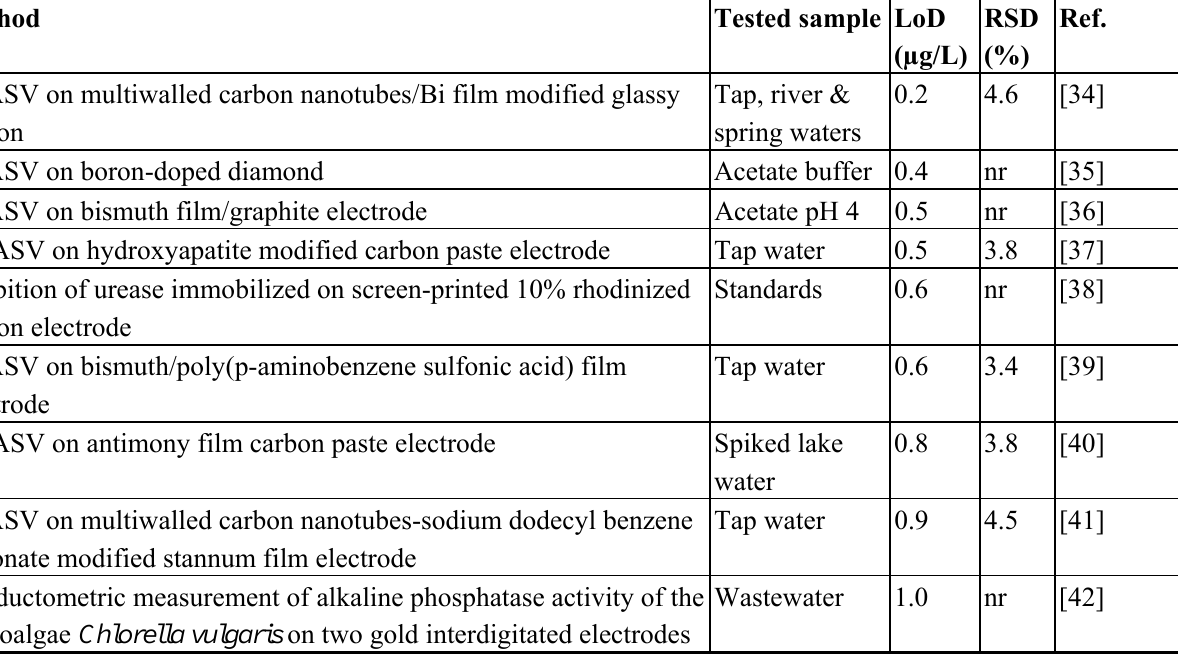
Table 2. Analytical characteristics of electrochemical sensors for cadmium determination in water, published between 2007 and